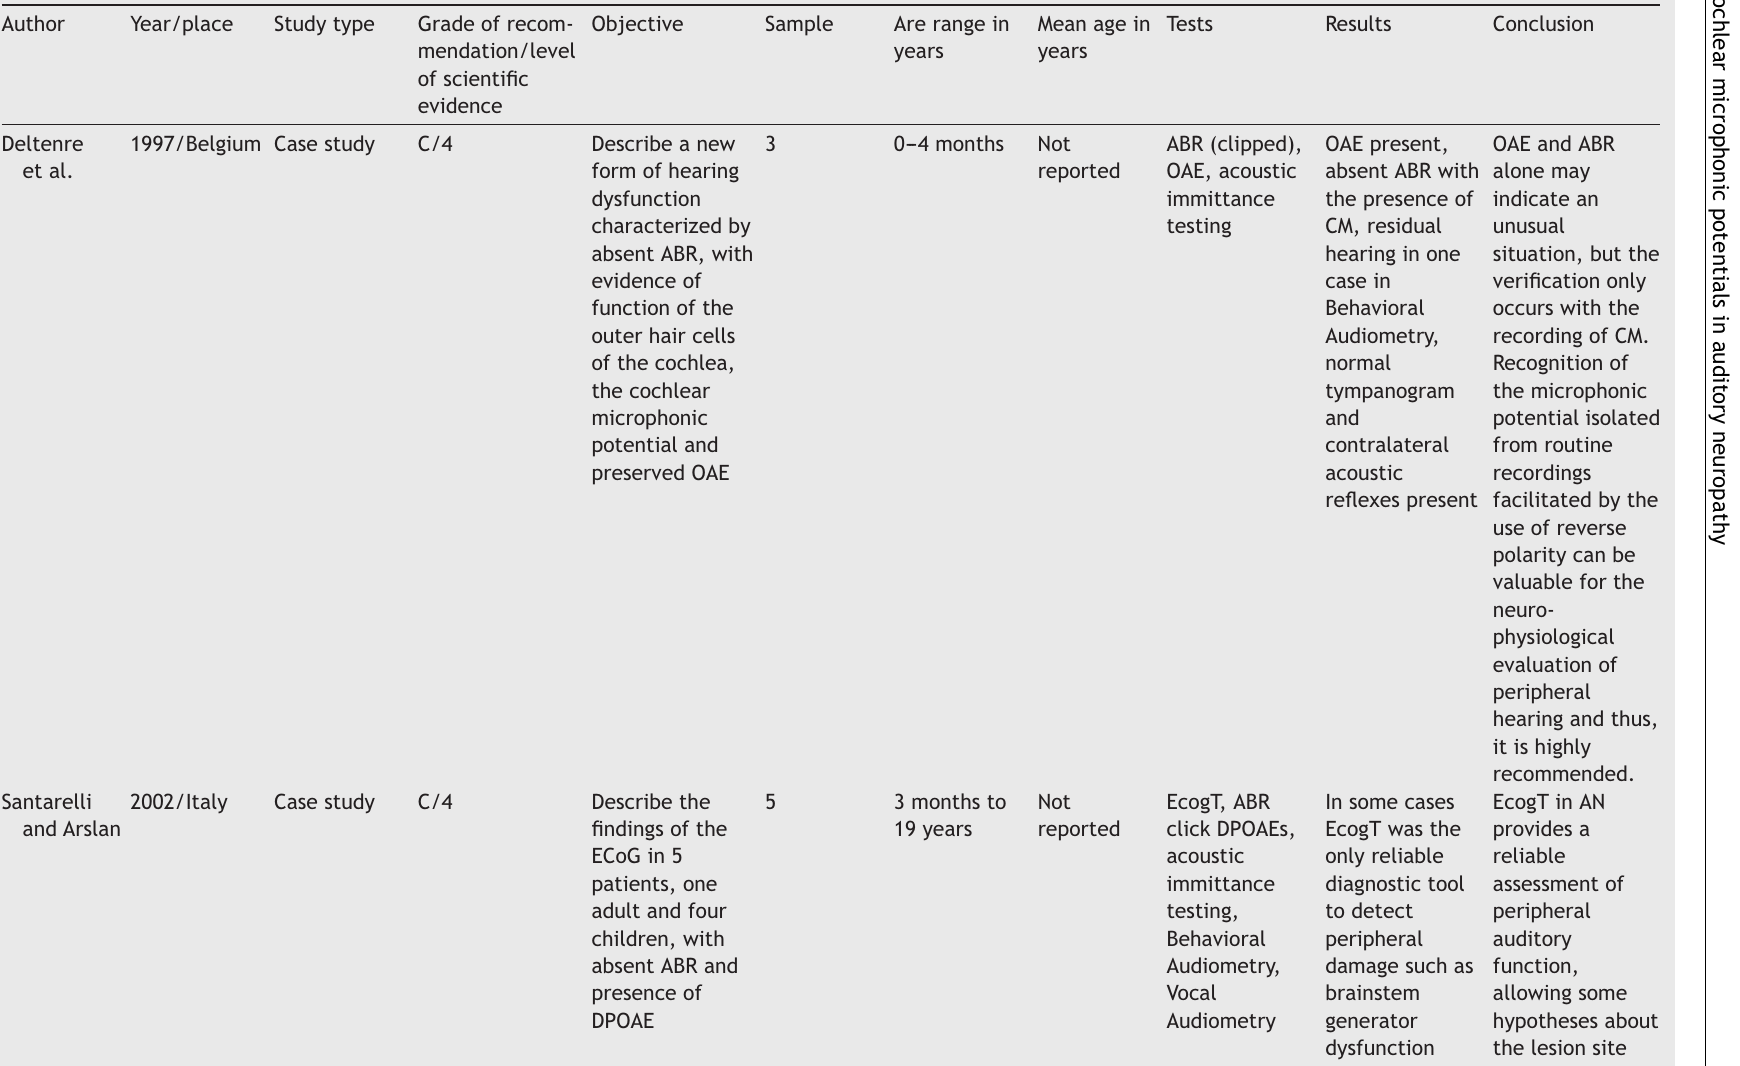
Summary with characteristics of the studies included in the